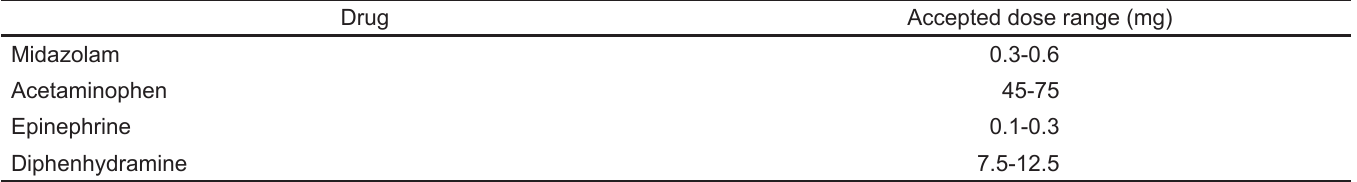
EMT, emergency medical